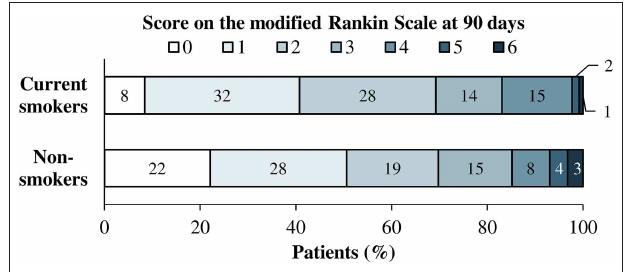
FIGURE 1 | Distribution of scores on the modified Rankin scale at 90 days according to smoking status.